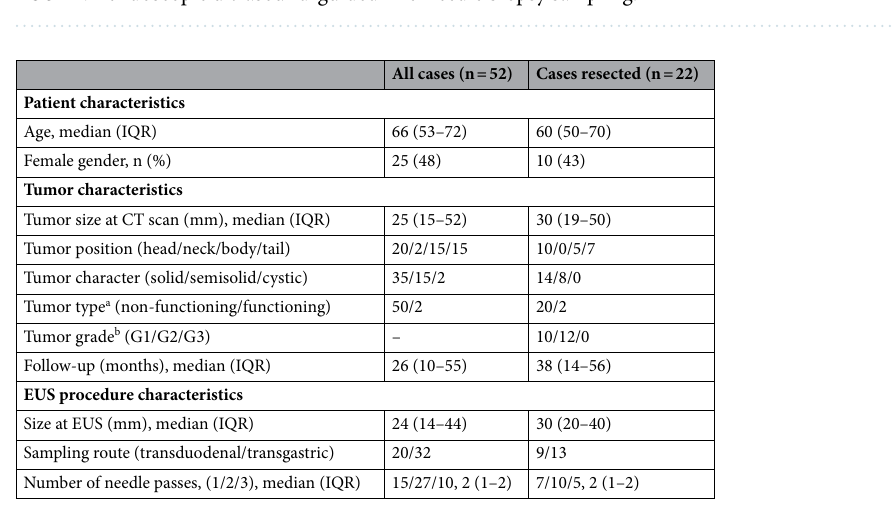
Figure 1. A flow chart of the enrolment process of the study cases. PanNET pancreatic neuroendocrine tumors, EUS-FNB endoscopic ultrasound-guided fine-needle biopsy sampling.